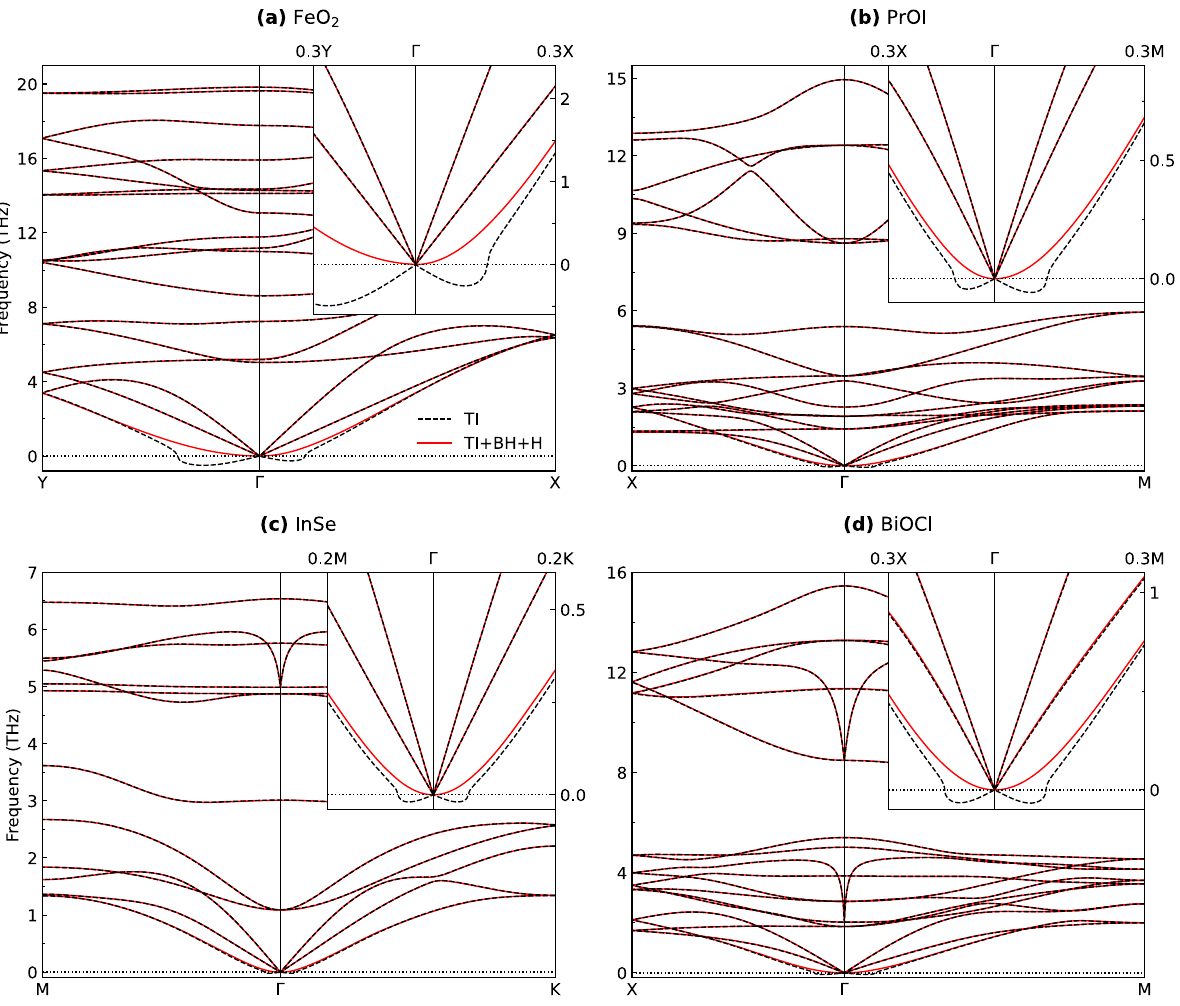
Fig. 7 Corrected phonon dispersions of four representative 2D materials from the 2D material database of Ref. 57 , (a) FeO 2 , (b) PrOI, (c) InSe and (d) BiOCl. The inset shows a zoom-in result around the Γ point. The black dashed lines are the results computed from the DFPT calculations with the translational invariance (TI) ful fi lled, while the red lines denote the results where the Born-Huang (BH) invariances and Huang (H) conditions have also been